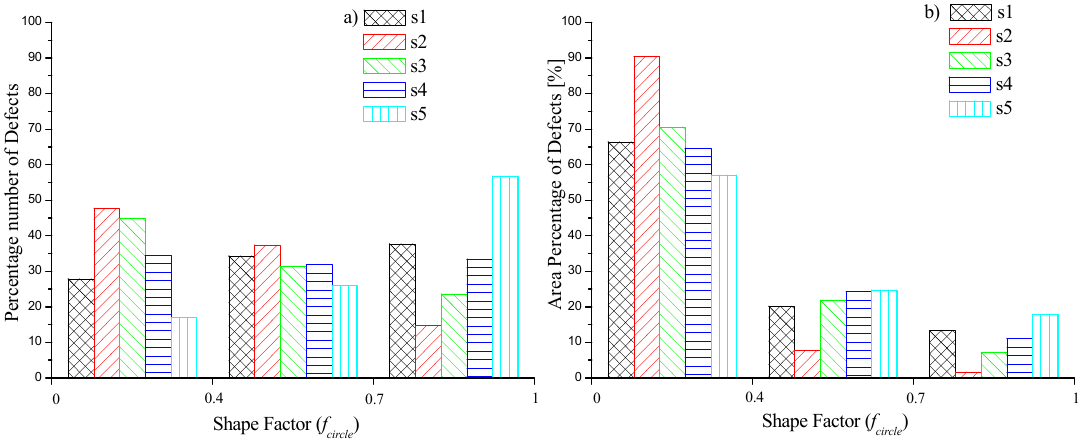
Figure 11. Analysis of the defects in the deposits cross-section. ( a ) percentage number of defects and ( b ) percentage area of defects vs the three classes of shape factor ( f circle ): (0–0.4) laminar defects, (0.4–0.7) spherical defects and (0.7–1) random shaped defects.